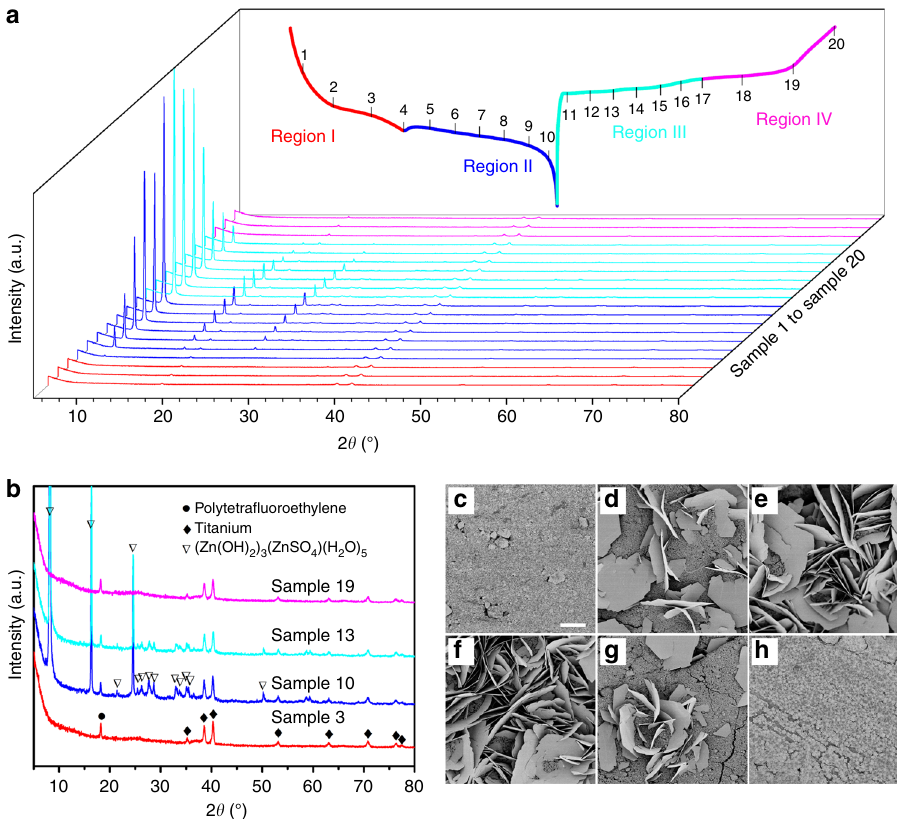
Fig. 3 Structure evolution of polyaniline-intercalated MnO 2 electrode during cycling. a Evolution of ex situ X-ray powder diffraction (XRD) patterns during the charge/discharge process (the vertical bars denoted with consecutive numbers indicate the locations where the XRD patterns were recorded). b Selected ex situ XRD patterns from a (corresponding to the XRD patterns denoted with 3, 10, 13, and 19 in a ), which represent the typical XRD pattern in each corresponding charge/discharge region. c – h Scanning electron microscopy (SEM) images for morphologic evolution of electrode during cycling (the SEM images were taken at the locations indicated by vertical bars 3, 5, 10, 12, 16, and 20 in a , respectively). Scale bars, c – h 10 μ m, respectively (the magni fi cation is the same for images c – h